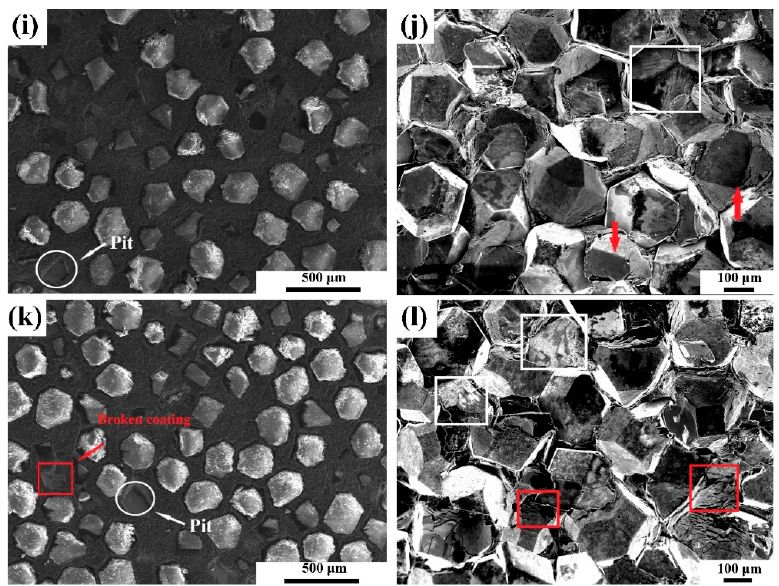
Figure 4. Microstructure and fracture surface of Mg/diamond composite with different coating temperatures: ( a , b ) uncoated, ( c , d ) 950 ◦ C/30 min, ( e , f ) 950 ◦ C/60 min, ( g , h ) 950 ◦ C/90 min, ( i , j ) 1000 ◦ C/30 min, and ( k , l ) 1050 ◦ C/30 min.